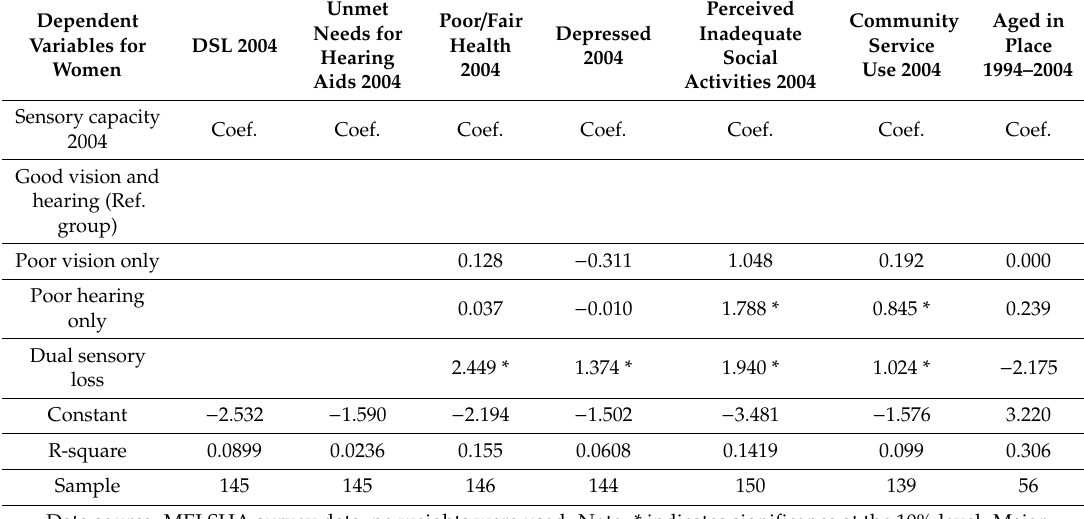
Table 11. Multivariate regression results on DSL incidence and its influences, 2004 women. Dependent Variables for